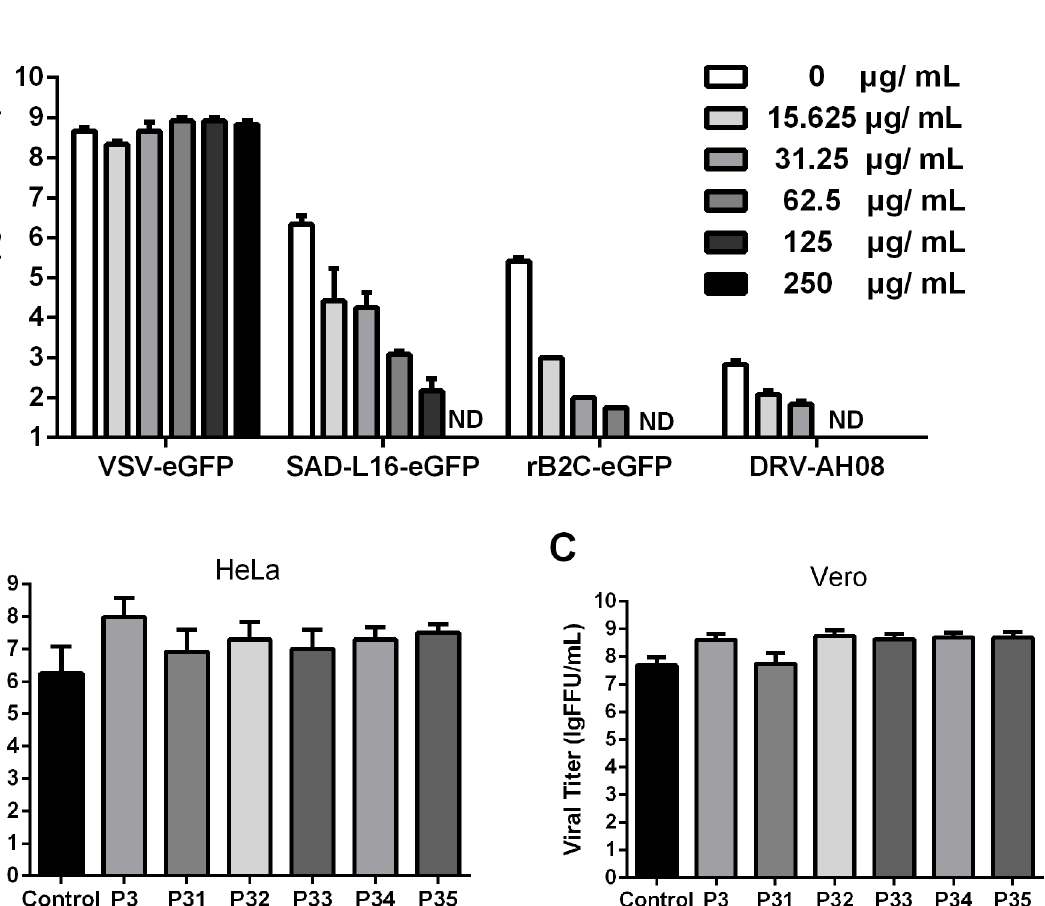
Fig 3. The inhibitory effects of P32 on VSV and different strains of RABV. (A) Confluent SK-N-SH cells were seeded in 24-well plates, and the viral titers of VSV and different strains of RABV were determined after incubating the cells with different concentrations of P32. Confluent HeLa cells (B) and Vero cells (C) were seeded in 24-well plates, and the viral titers of VSV were determined after incubating with different carrageenans (P3, P31, P32, P33, P34, and P35) at 250 μ g/mL. Each value is expressed as the mean ± SEM from three independent experiments. ND means non-detectable.